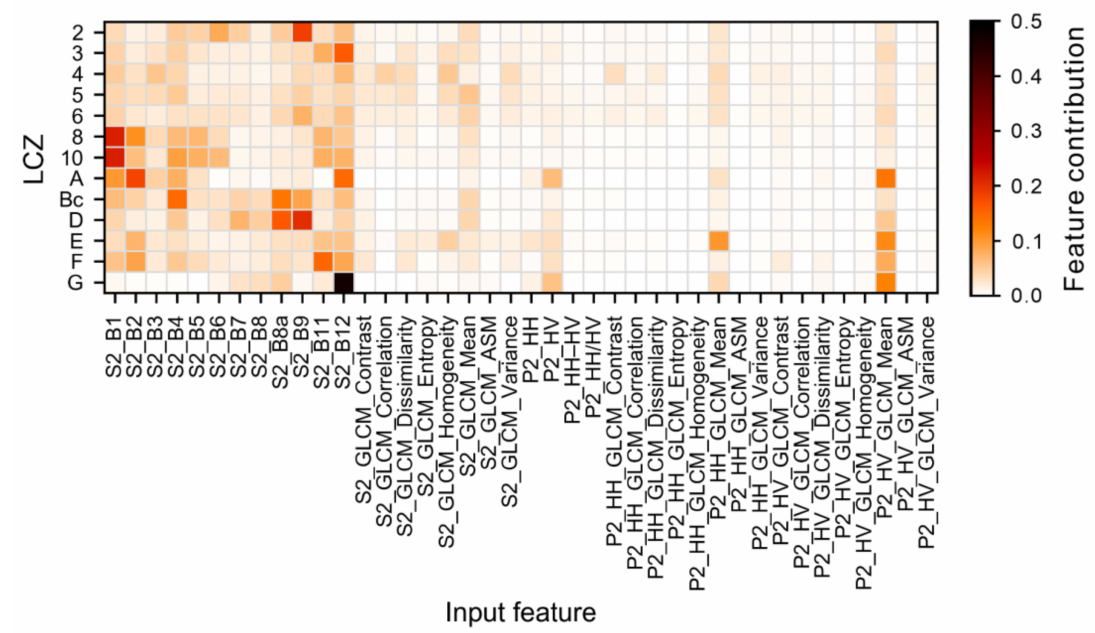
Figure 10. Mean of feature contributions for each LCZ class for the RF model using the training set